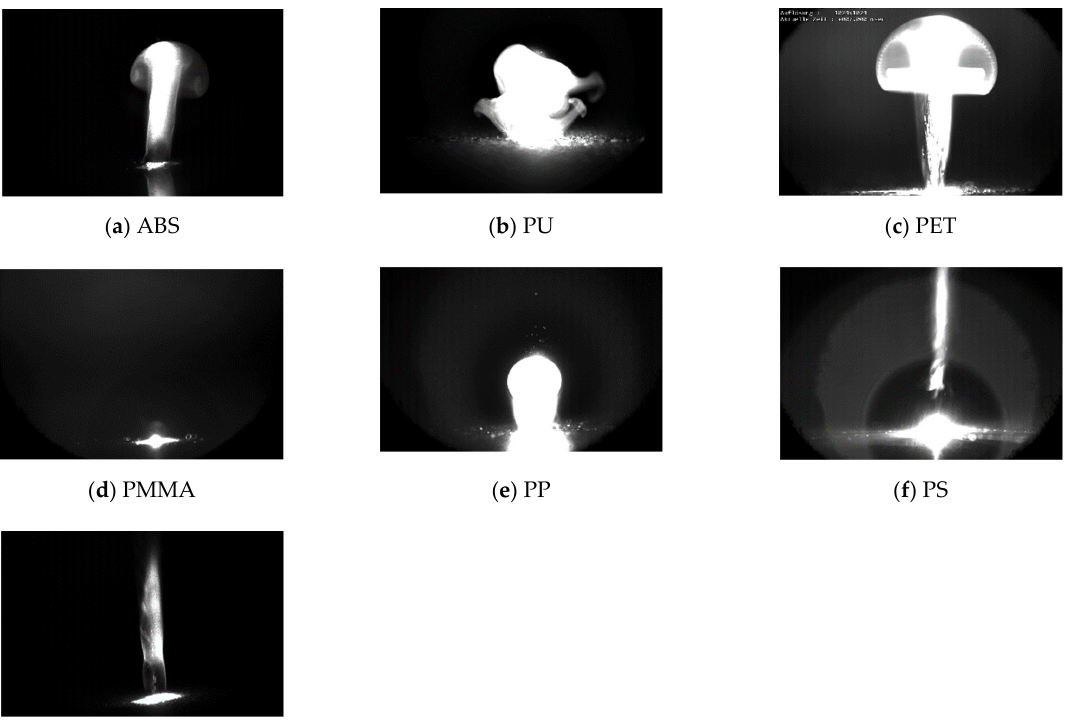
Figure 7. Photo of the ablation after the material received a pulse salvo containing 55 single laser pulses. Ablated particles reflect the laser light and make the plume visible. For scale: the size of the focal spot is between 0.2 and 0.5 mm in each case.